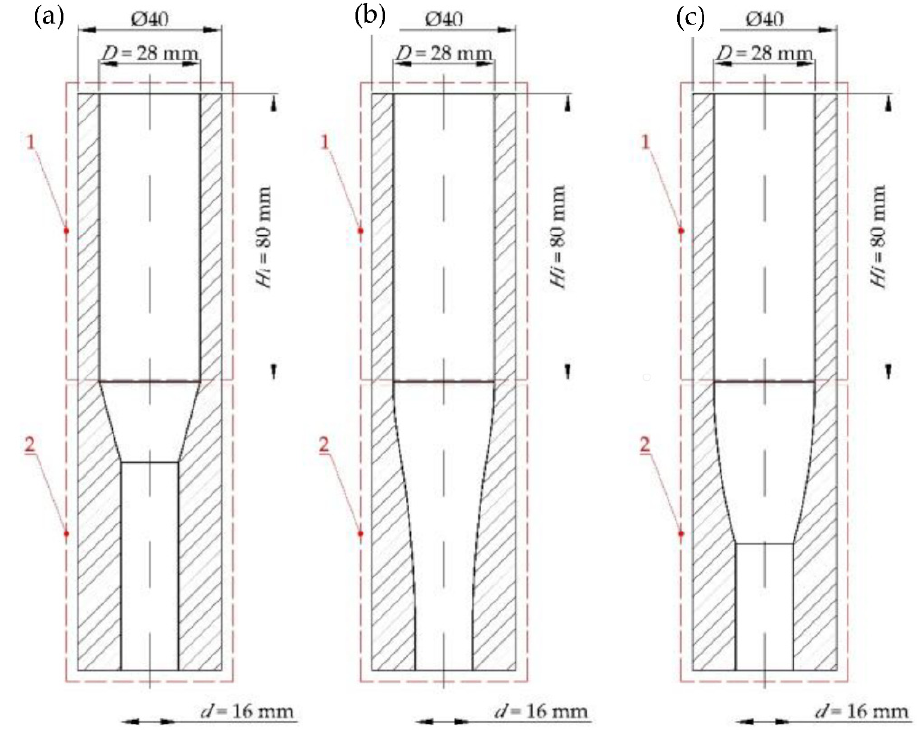
Figure 5. Shapes of integrated single-hole dies (examples): ( a ) CS incl. cylindrical section, ( b ) WKWP incl. cylindrical section, ( c ) WP incl. cylindrical section; 1—feed barrel area, 2—compression cavity area; D —feed barrel diameter, H —feed barrel height, d —outlet diameter commensurate to the diameter of the produced pellets.